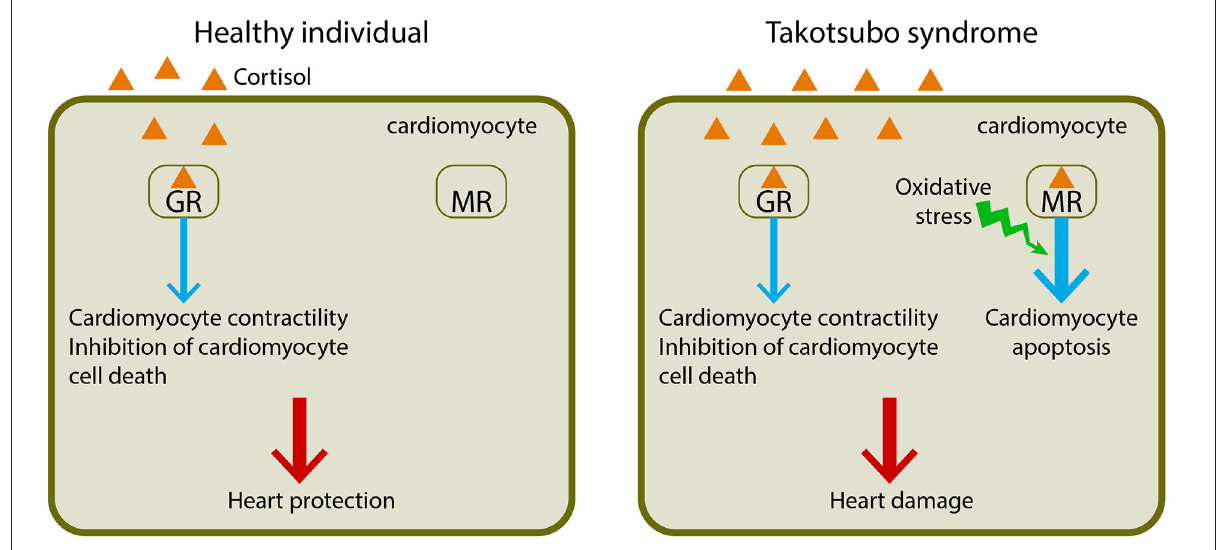
FIGURE2 Dual effects of cortisol in cardiomyocyte function. Cortisol exerts its actions on the cardiomyocyte by binding two nuclear receptors, the glucocorticoid receptor (GR) and the mineralocorticoid receptor (MR). In a healthy individual, cortisol binds to the glucocorticoid receptor and activates its signaling, leading to enhanced cardiomyocyte contractility and inhibited cardiomyocyte death, thus protecting the heart. In a patient with Takotsubo syndrome, the increased cortisol binds not only to the glucocorticoid receptor but also to the mineralocorticoid receptor, leading to cardiomyocyte apoptosis in the presence of oxidative stress, which is often associated with Takotsubo syndrome, and thus resulting in heart